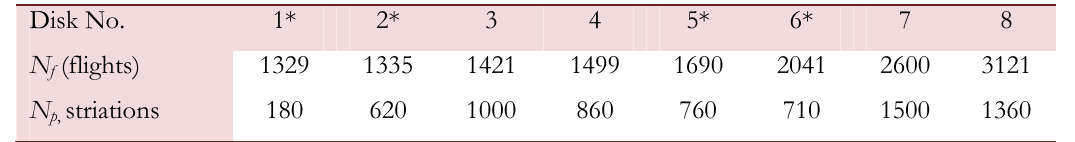
Table 2: Operating times N of the disks since new and a calculated number N f (*In disks-No 1, 2, and 5, 6 cracks did not reach their critical